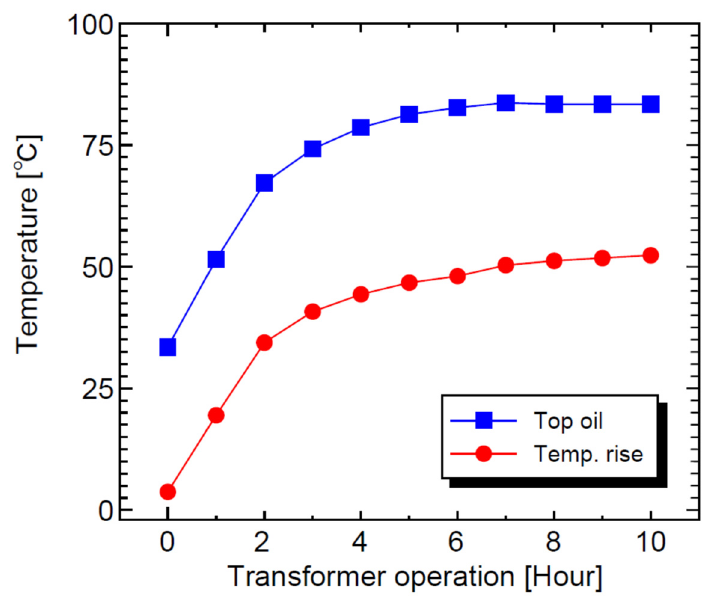
Figure 12. The oil temperature during transformer operation.